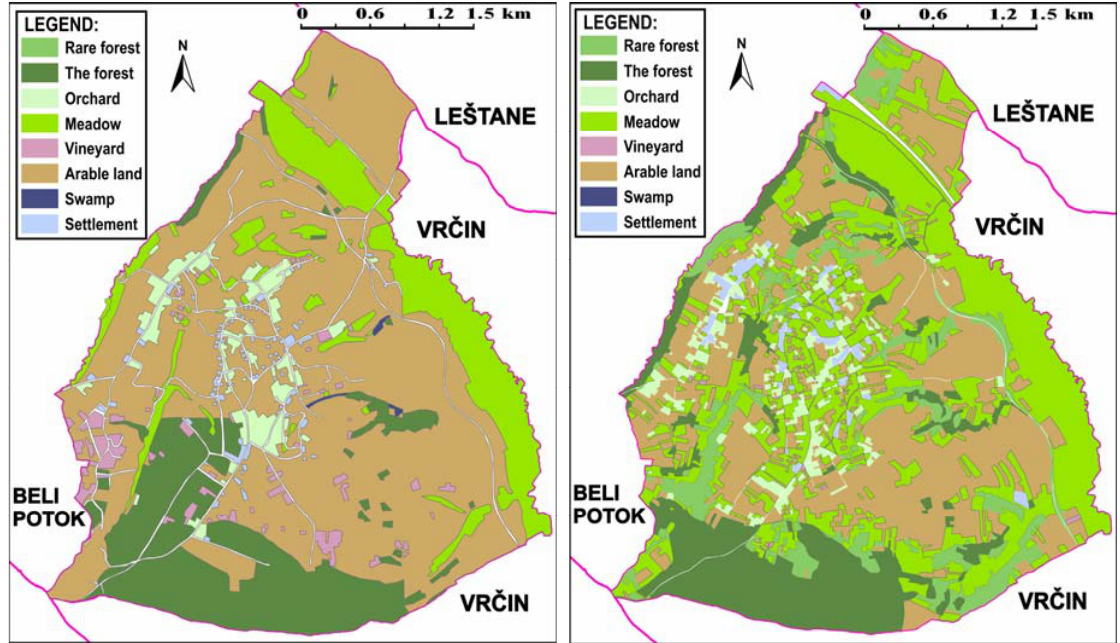
Figure 2. Example of land-use maps for 1970 ( left ) and 2018 ( right ) for the settlement of